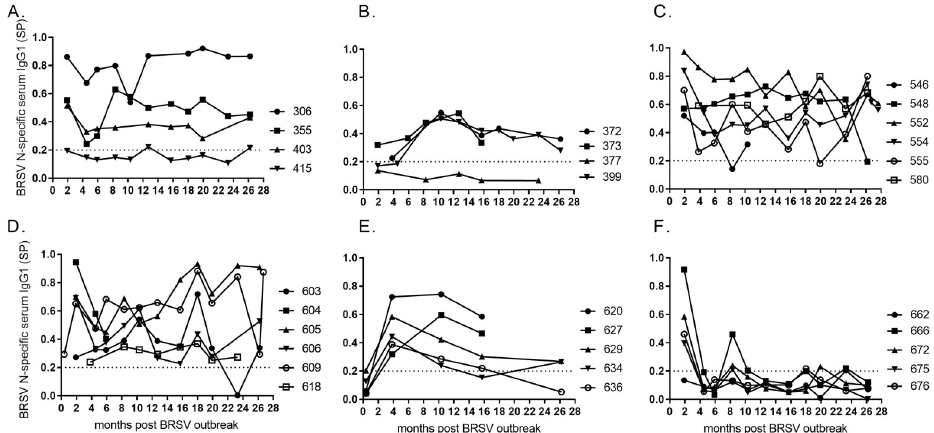
Fig 6. Kinetics of HRSV N-specific serum IgG1 antibodies in cattle of different age and production status. At the time of a BRSV outbreak the cattle were (A) 23–30 months old ( < 6 months gestation), (B) 24–26 months old ( > 6.5 months gestation), (C) 7–11 months old, (D) 4–5 months old, (E) 2–3 months old, or (F) born during or just after the outbreak in January 2016 (month 0). For each serum sample, the optical density (OD) against a control antigen was subtracted from the OD value against the N protein (Corrected OD, COD) and the COD was transformed into a sample-to-positive value (SP) by using the formula SP = COD sample /(COD pos —COD neg ).